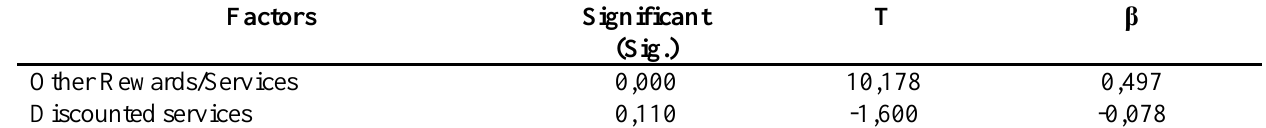
Table 8. Regression analysis of behavioral commitment variable